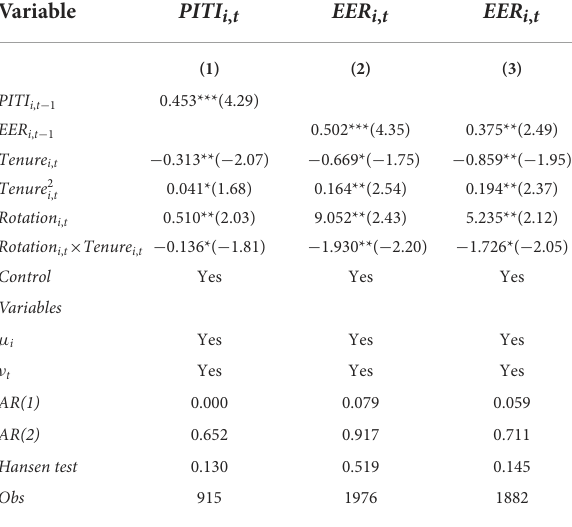
TABLE 3 Robustness